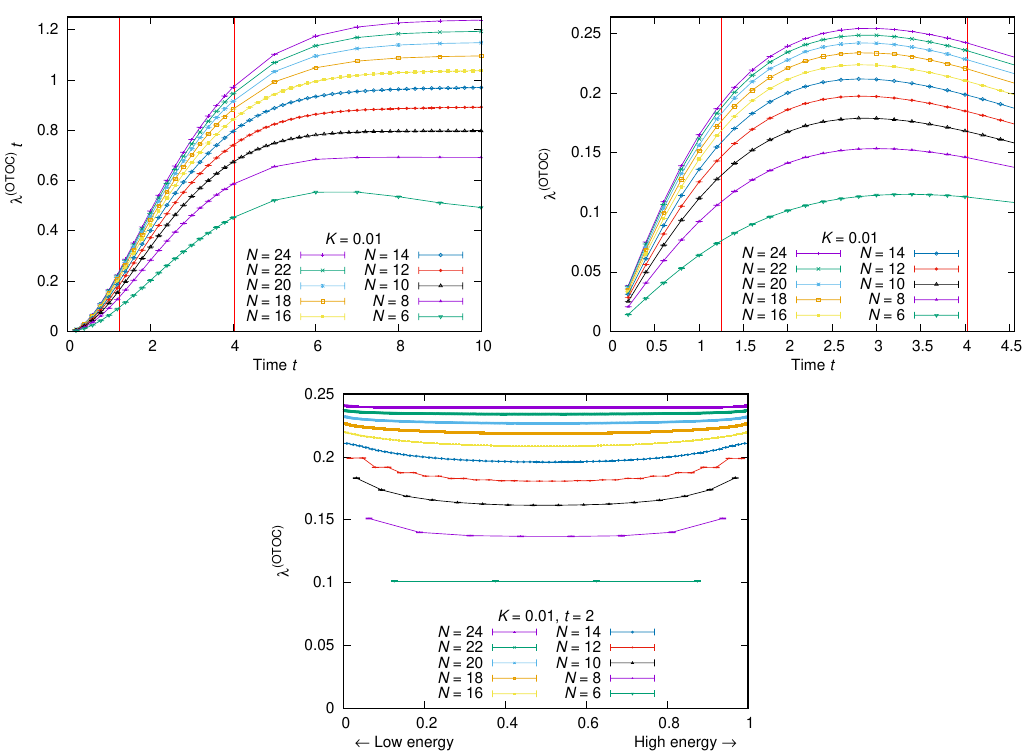
Figure 5 . The generalized SYK model with K = 0 : 01. [Left] The Lyapunov growth from OTOC, the almost linear dependence on time t of (cid:21) (OTOC) t = 1 for N = 24 ; 22 and 1000 samples for N = 20 ; 18 ; : : : ; 6 are used. Vertical lines correspond to 20% and 80% for N = 20. [Middle] The Lyapunov exponent estimated from OTOC, (cid:21) (OTOC) (cid:17) (cid:16) (cid:17) P N 1 1 log e 2 (cid:21) i t . [Right] At each N , the exponent (cid:21) (OTOC) at t = 2 is shown as the function i =1 2 t N of the energy E i . The horizontal axis is ( i + 1 = 2) =L , so that the left and right corresponds to low and high